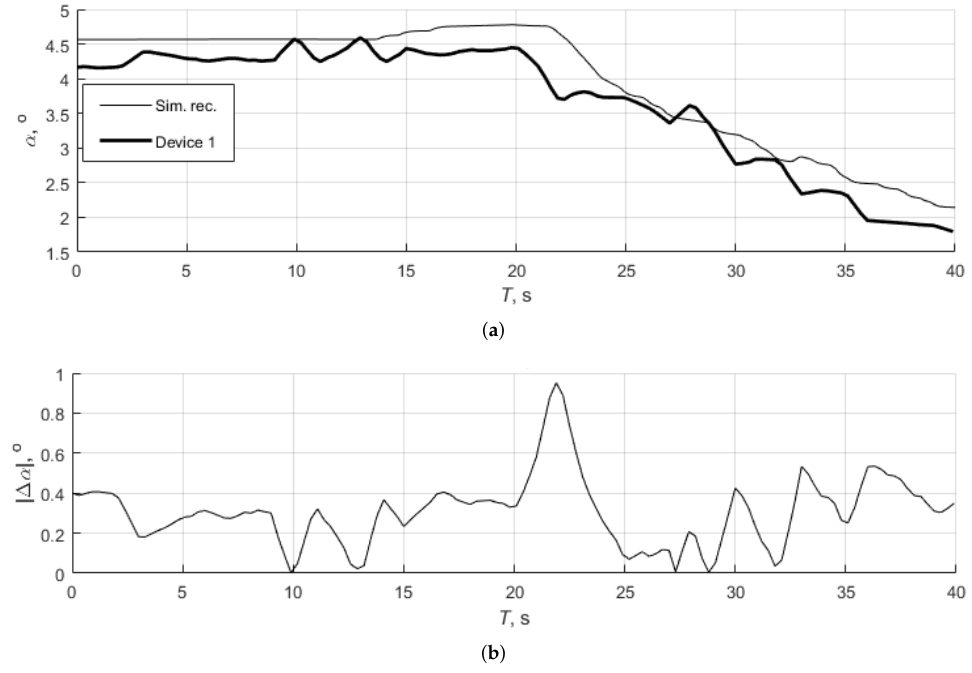
Figure 5. The estimated AoA: ( a ) from the flight simulator “Sim.rec.” and test flight data “Device 1”; ( b ) absolute difference between the “Sim.rec.” and “Device